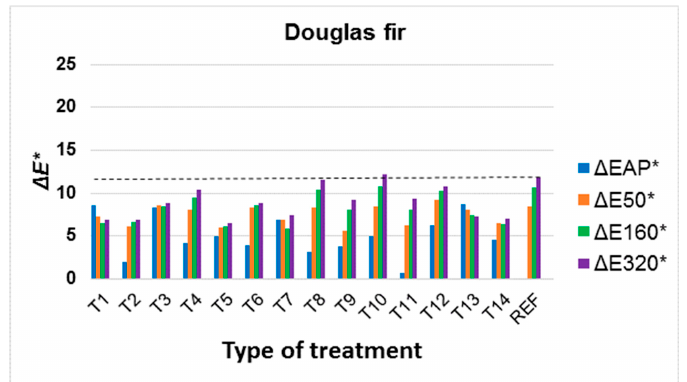
Figure 6. Colour changes in Douglas fir wood after application of surface treatment ( Δ EAP*) and after 50, 160 and 320 h ( Δ E50*, Δ E160*, Δ E320*) of accelerated ageing. (All evaluated total colour changes Δ E* in graph were compared to untreated wood surface.)